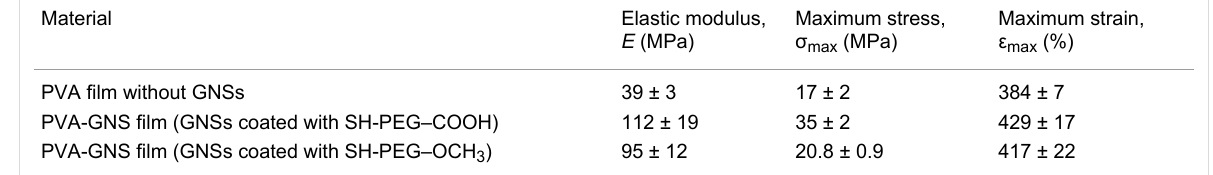
Table 1: Mechanical parameters obtained by tensile tests of PVA, PVA-gold nanostars (GNS) (GNSs coated with SH-PEG–COOH) and PVA-GNS (GNSs coated with SH-PEG–OCH 3 ) films. Material